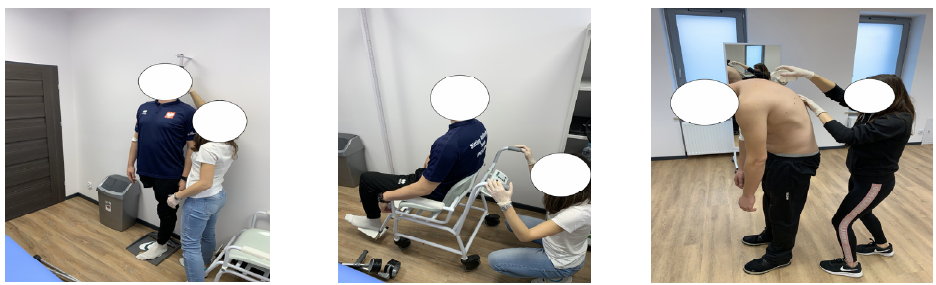
Figure 1. Examples of anthropometric measurements and spinal curvature measurements.